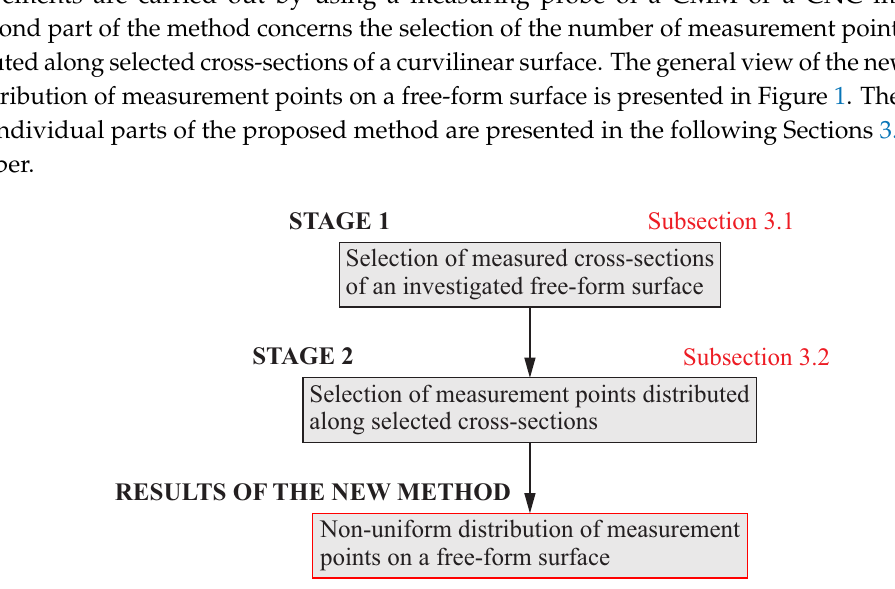
Figure 1. The general view of the proposed method of the distribution of measurement